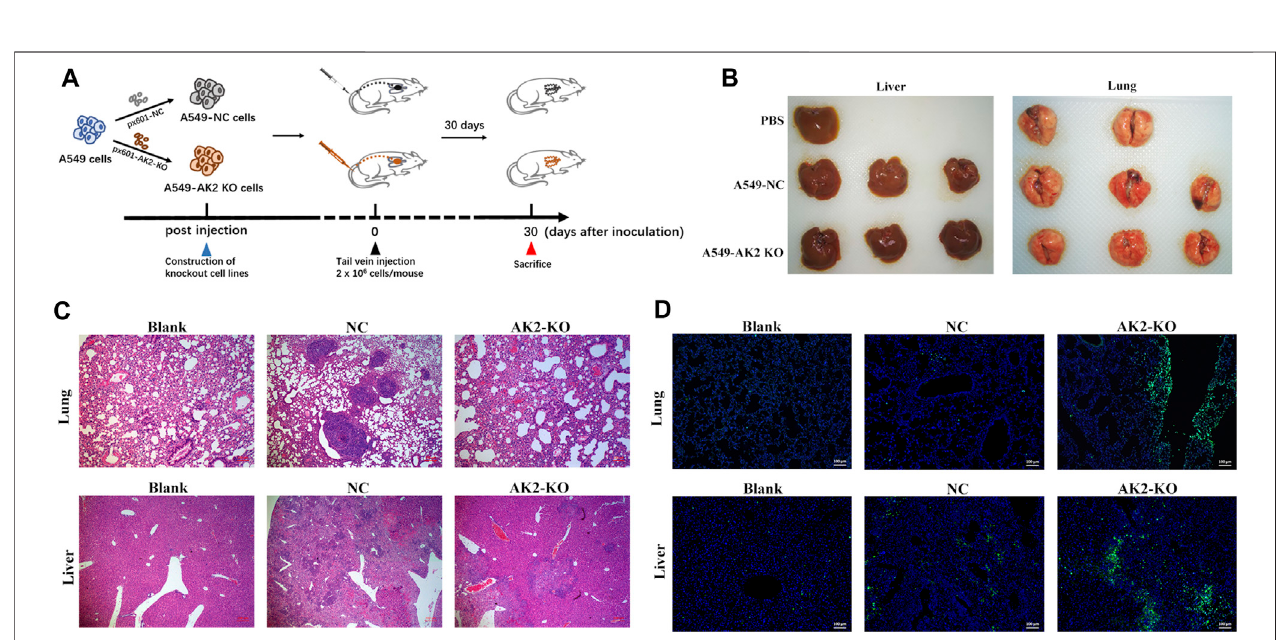
FIGURE 5 | AK2 promotes lung cancer cell invasion in vivo . (A) The schematic diagram of establishing a lung cancer metastasis model by tail vein injection. (B) Representativewholeorganimagingofliver (left) andlung (right) innudemiceinjectedwithA549-NCorA549-AK2KOcells. (C) Representativeparaf fi nsectionsoflung and liver tissues stainedwithH&E innudemice injected withA549-NC or A549-AK2 KO cells.Bars indicate 100 μ m. (D) Representativeimmuno fl uorescenceimagesof labeled epithelial marker (E-cadherin) of lung and liver in nude mice injected with A549-NC or A549-AK2 KO cells. Bars indicate 100 μ m n (cid:2) 6 mice in each group.